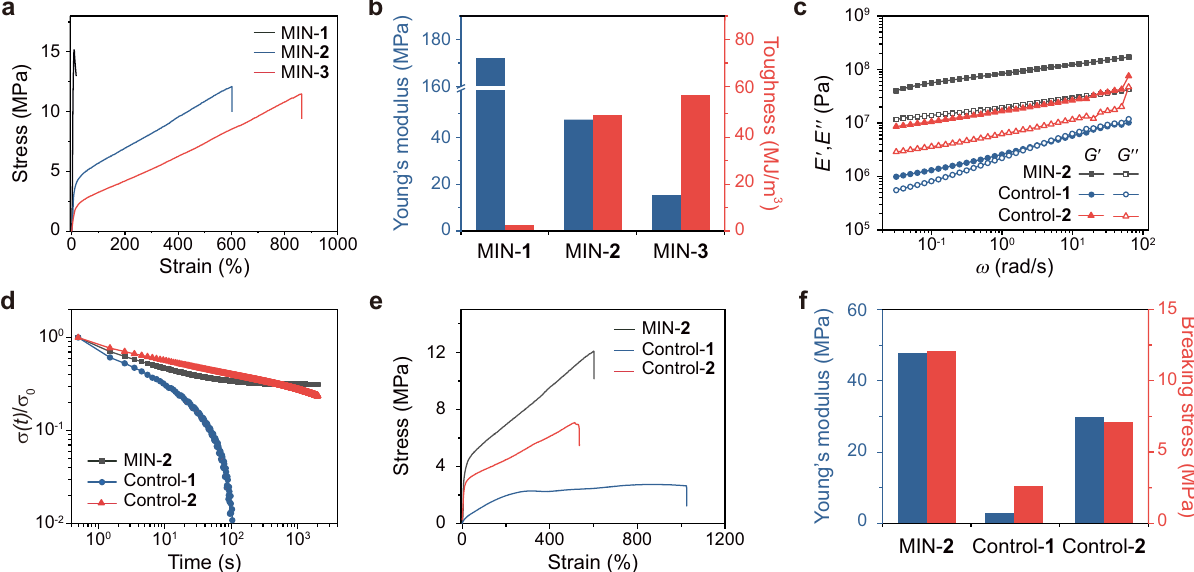
Fig. 4 Mechanical properties of MINs and controls. a Stress – strain curves of MINs- 1 − 3 were recorded with a deformation rate of 100 mm/min. b Young ’ s moduli and toughness of MINs- 1 − 3 calculated from their stress – strain curves. c Frequency sweep of MIN- 2 and two controls measured by DMA. d Normalized stress relaxation curves of MIN- 2 and two controls measured at 30 °C. e Stress − strain curves of MIN- 2 and two controls recorded with a deformation rate of 100 mm/min. f Young ’ s moduli and breaking stress of MIN- 2 and two controls calculated from their stress – strain curves. performance of molecular necklaces as a cross-linker. Tensile tests of MINs- 1 − 3 showed that Young ’ s moduli of the samples increased with the cross-linking density, and the values are cal- culated to be 172, 47.3, and 15.5 MPa for MIN- 1 , - 2 , and - 3 ,